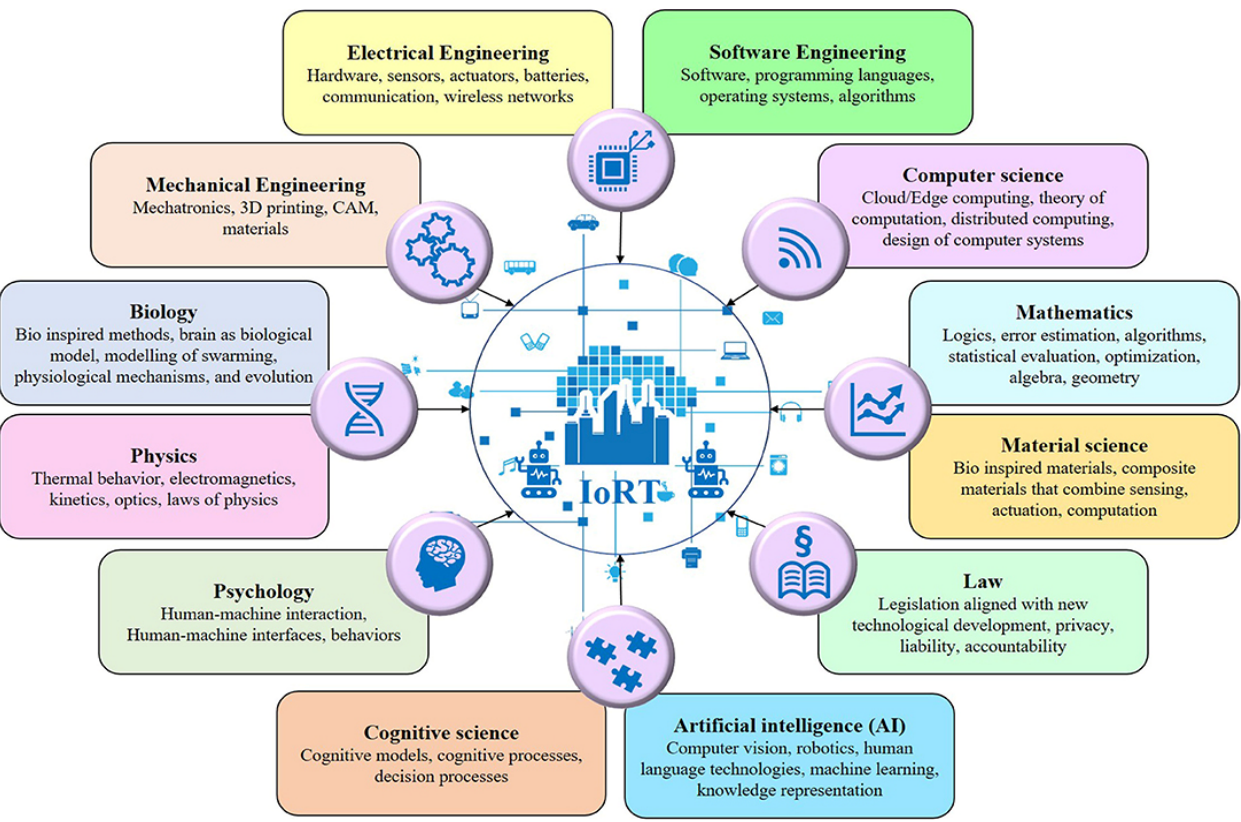
Figure 17. Outline of different fields of study and research perspectives on mobile robots [105].